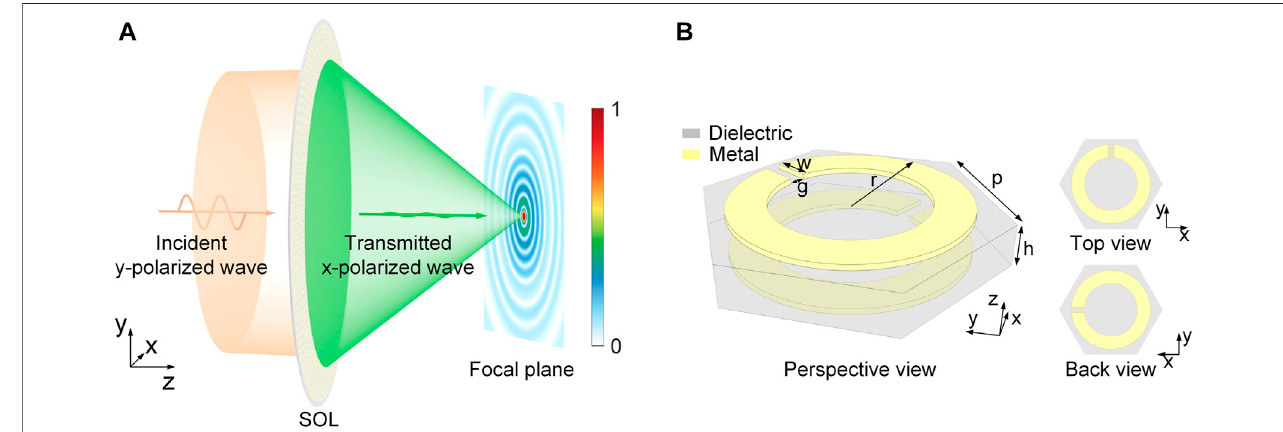
FIGURE 1 | (A) Schematic diagram of the proposed superoscillatory lens (SOL). (B) Geometric structure diagram of the proposed chiral structure.